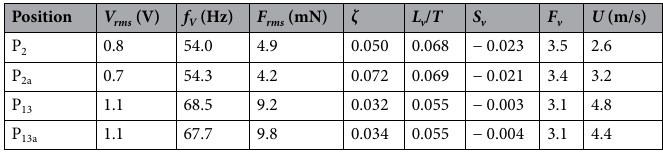
Table 4. Results obtained for SFG at positions P 2 vs. P 2a and P 13 vs. P 13a .